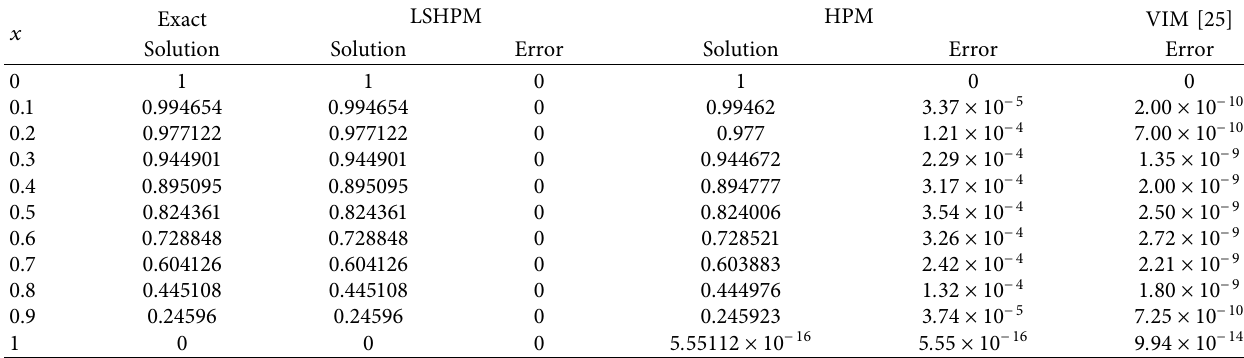
Table 5: Comparison of first-order absolute error of LSHPM with HPM and VIM in Problem